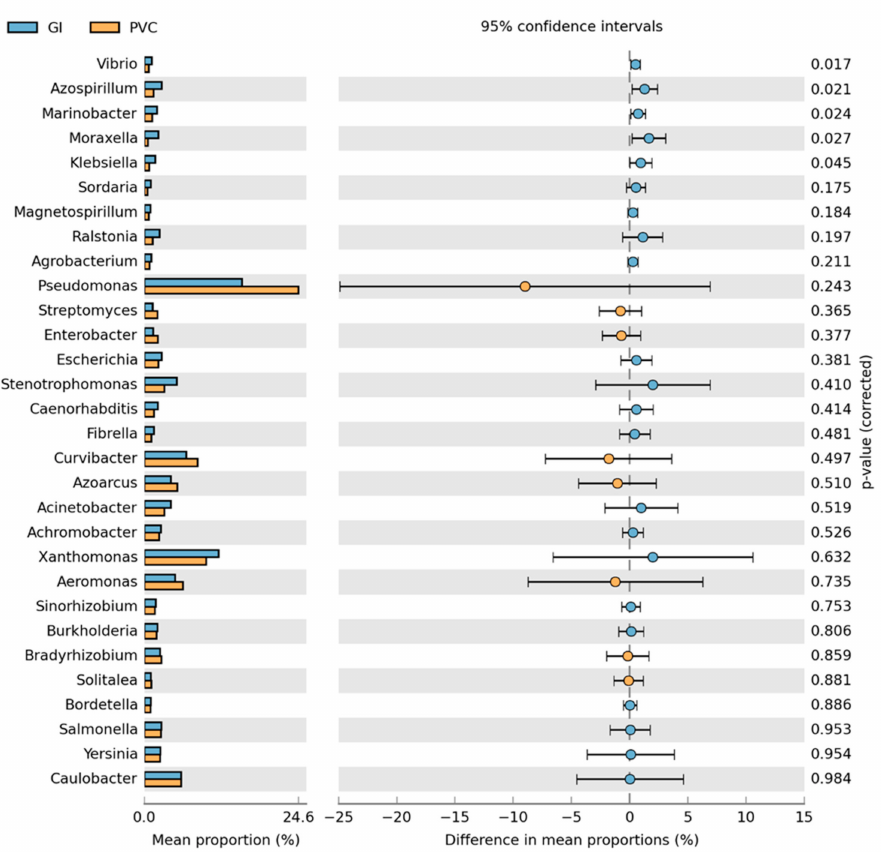
Figure 6. Differential abundance profile (genus level) between GI and PVC pipe biofilm samples on the basis of Fischer’s exact t -test with Storey’s FDR correction at 95% confidence